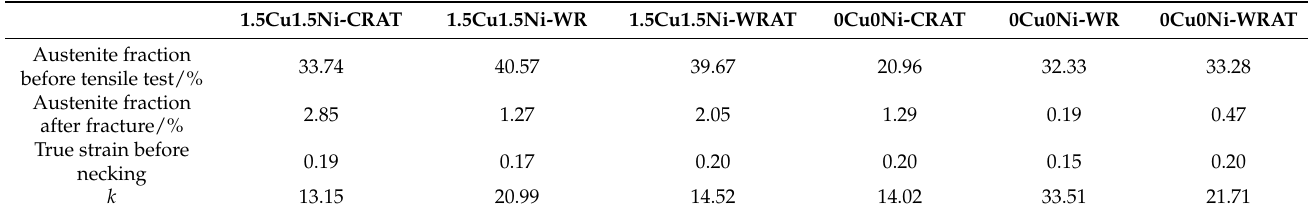
Table 4. k values of the 1.5Cu1.5Ni and 0Cu0Ni